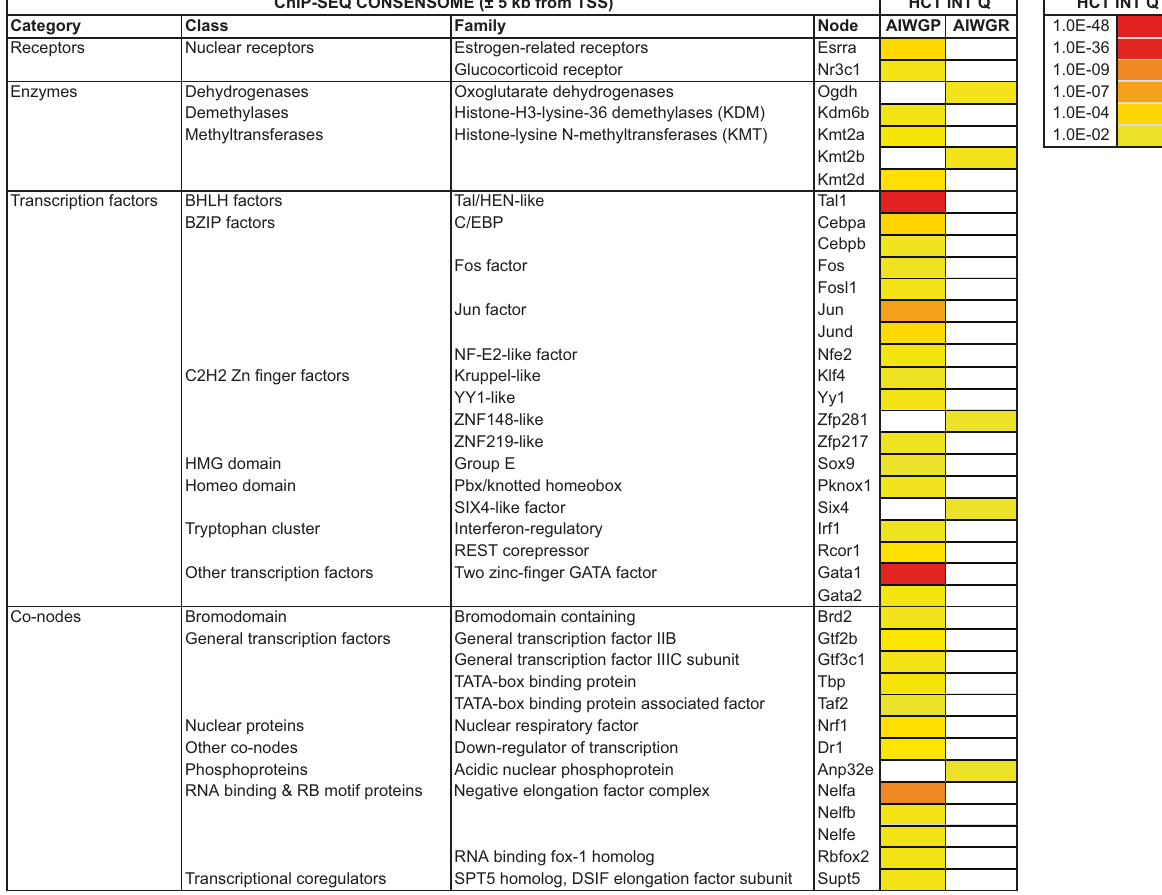
Fig. 4 ChIP-Seq high-con fi dence transcriptional target (HCT) intersection analysis of the AIWG-P and AIWG-R gene sets and mouse signaling nodes. q -values were generated using the GeneOverlap analysis package in R as previously described (Ochsner et al. 2020) [23]. White cells represent q > 5e-2 intersections. Shown are q < 0.01 intersections; full numerical data are provided in Supplementary fi le section 4. The universe for the intersection was set at a conservative estimate of the total number of transcribed genes in the mouse genome (30,000; [71]). Table 1. Candidate biomarkers of AIWG in mouse and human studies. FC Pr/Res ( p < 0.05) Symbol